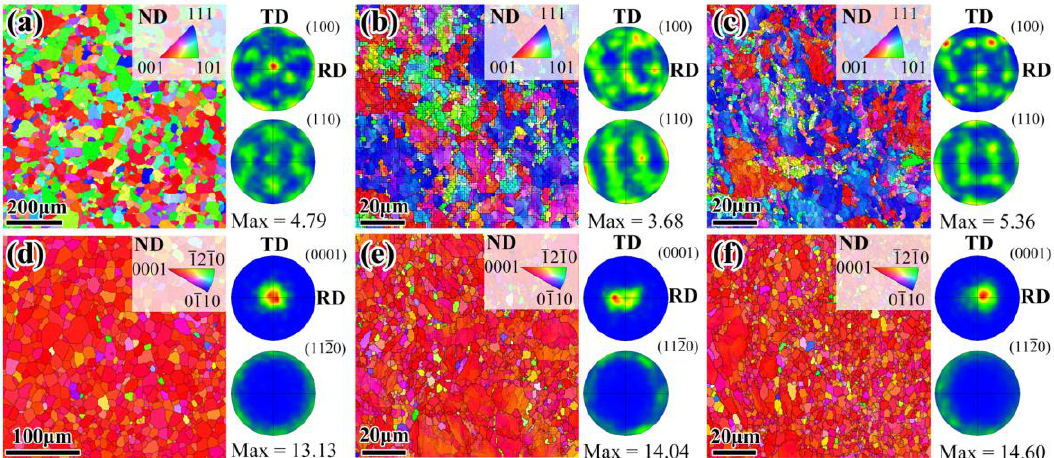
Figure 5. Inverse pole figure and pole figure of the raw sheets and as - rolled composite sheets: ( a ) Al and ( d ) Mg raw sheets, ( b ) Al and ( e ) Mg layers in Mg/Al sheet, and ( c ) Al and ( f ) Mg layers in Mg/Al - Ti sheet. RD, TD, and ND refer to the rolling direction, transverse direction, and normal direction, respectively.